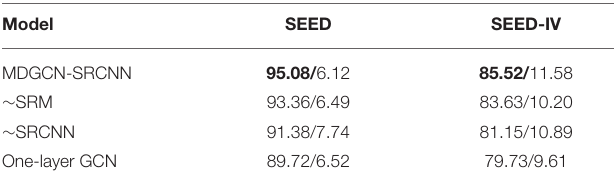
TABLE 5 | The results of ablation experiments on SEED and SEED-IV (mean/std), “ ” represents the module is ∼